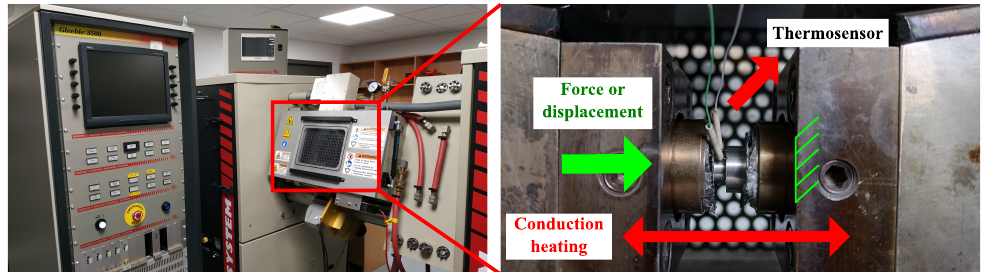
Figure 2. Gleeble 3800 test bench with the positioning of the hat-test specimen: the force (or dis- placement) is applied by a mobile die, and the temperature is induced by thermal conduction and is controlled with a type K thermocouple. For more information please see [51].